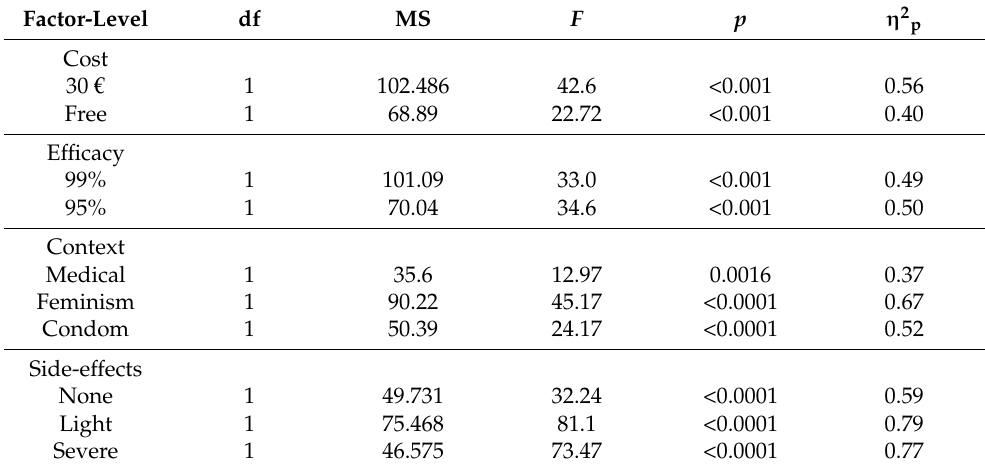
Table 4. Results of One-way ANOVA: The effects of the Country on the Factor-levels.